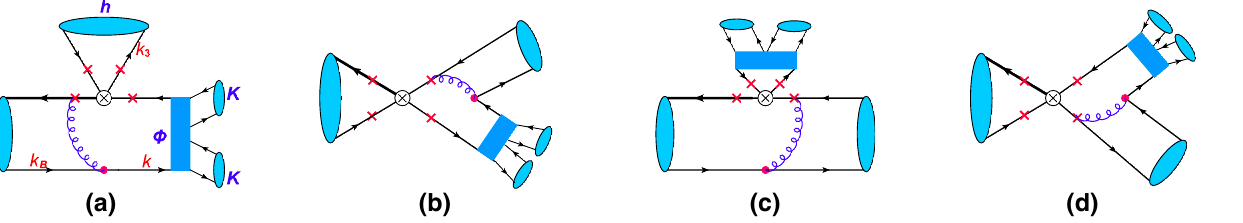
Fig. 1 TypicalFeynmandiagramsfor B → φ( 1020 , 1680 ) h → K Kh decays. The symbol × denotes the possible attachments for hard glu- ons, the symbol φ and the rectangle represent the resonances φ( 1020 ) and φ( 1680 ) . The symbol ⊗ is the weak vertex, B , K and h stand for